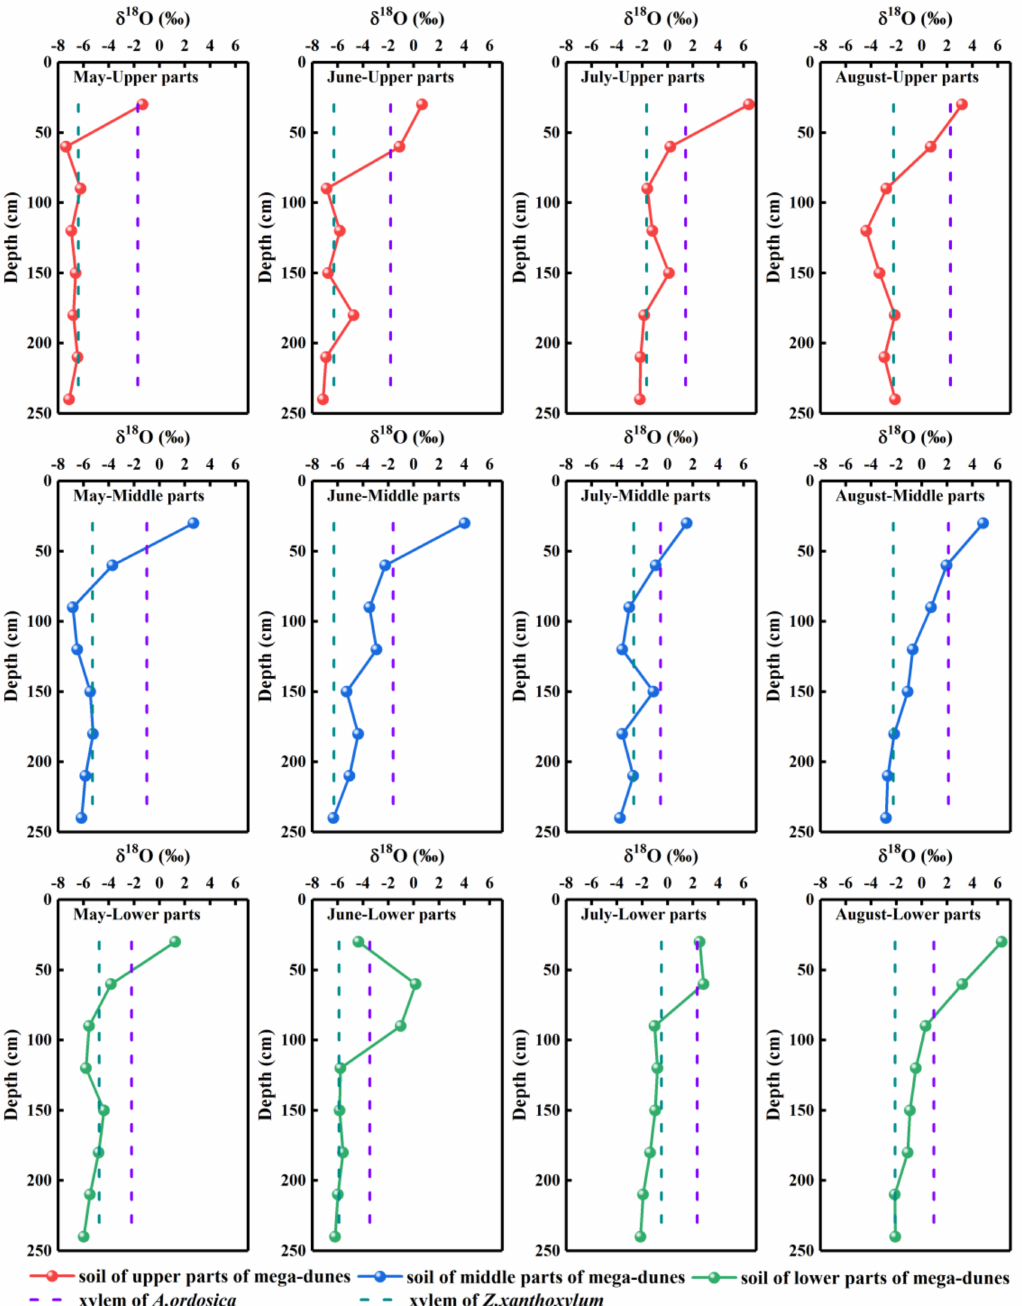
Figure 5. Spatio-temporal variations in δ 18 O values of plant xylem water and soil water. Rows one to three present the δ 18 O values of plant xylem water and soil water from the upper, middle, and lower parts of mega-dunes, respectively. Columns one to four present the δ 18 O values of plant xylem water and soil water in May, June, July, and August, respectively. The average δ 18 O values in xylem water of Z. xanthoxylum ranged from − 6.40‰ to − 0.48‰, while those of A. ordosica ranged from − 3.47‰ to 2.33‰. The δ 18 O values